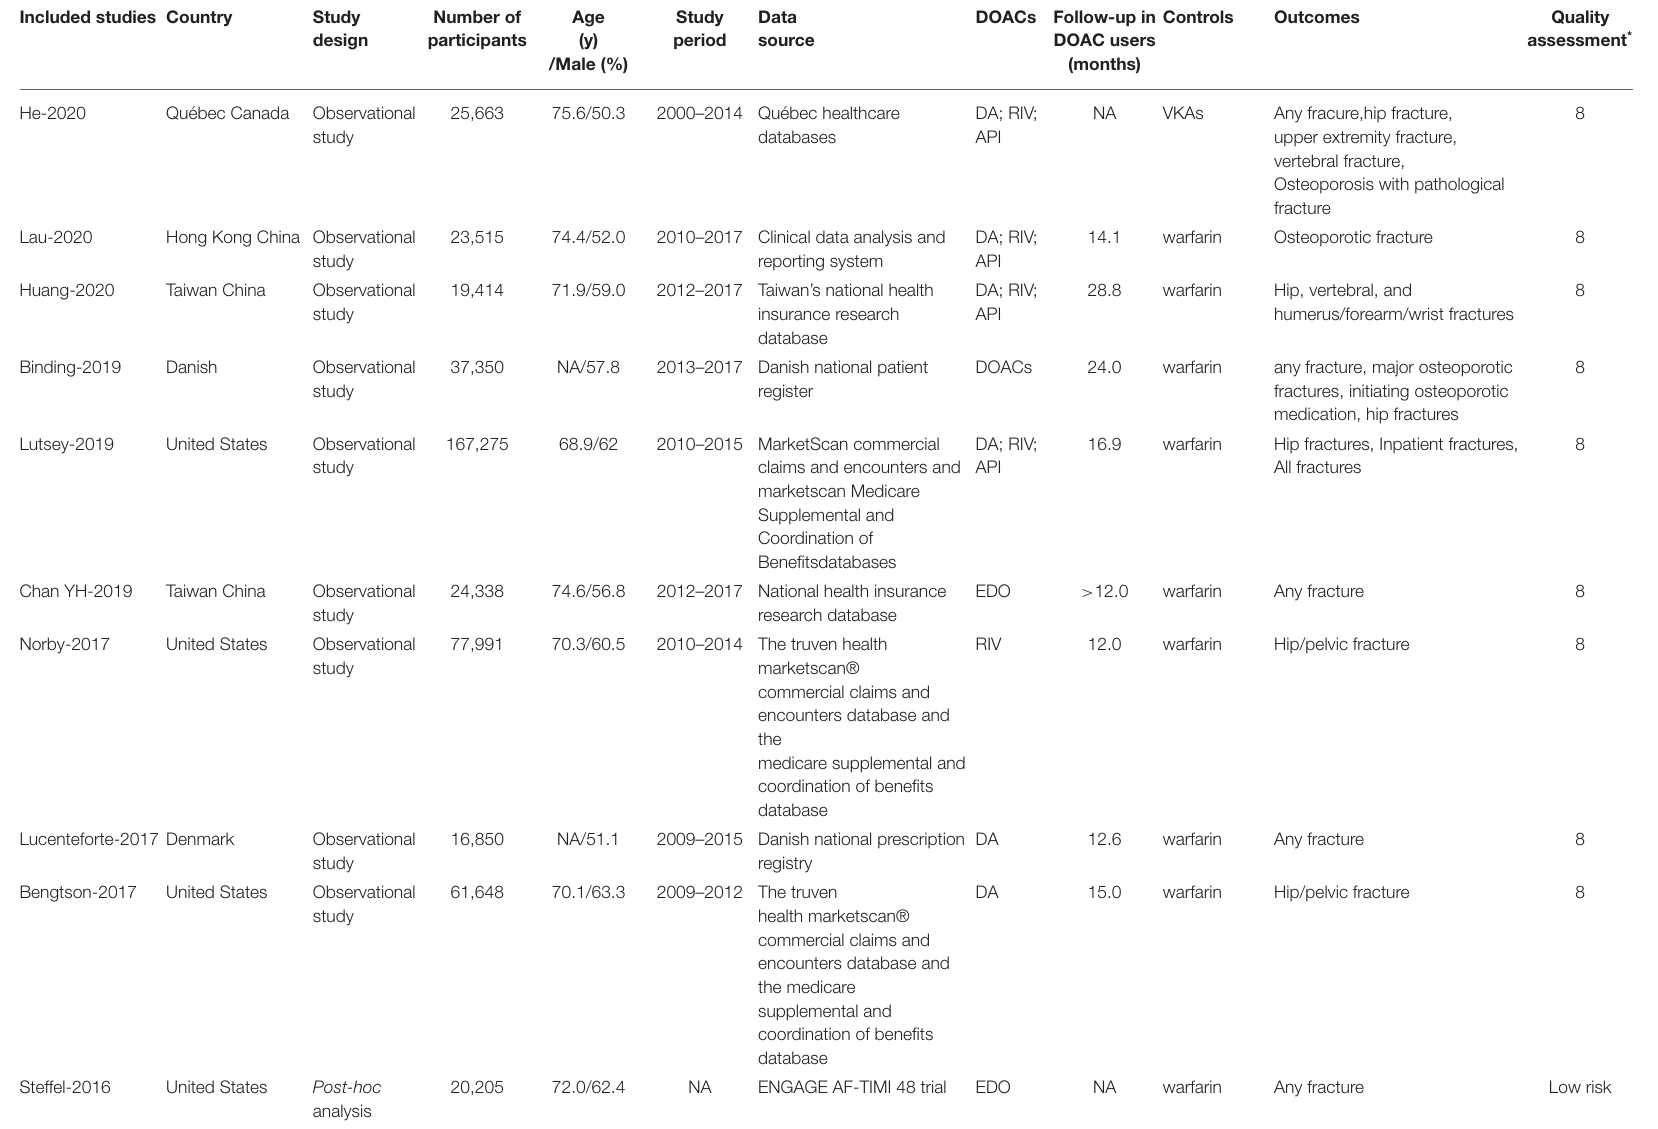
TABLE 1 | Baseline characteristics of the included studies of this